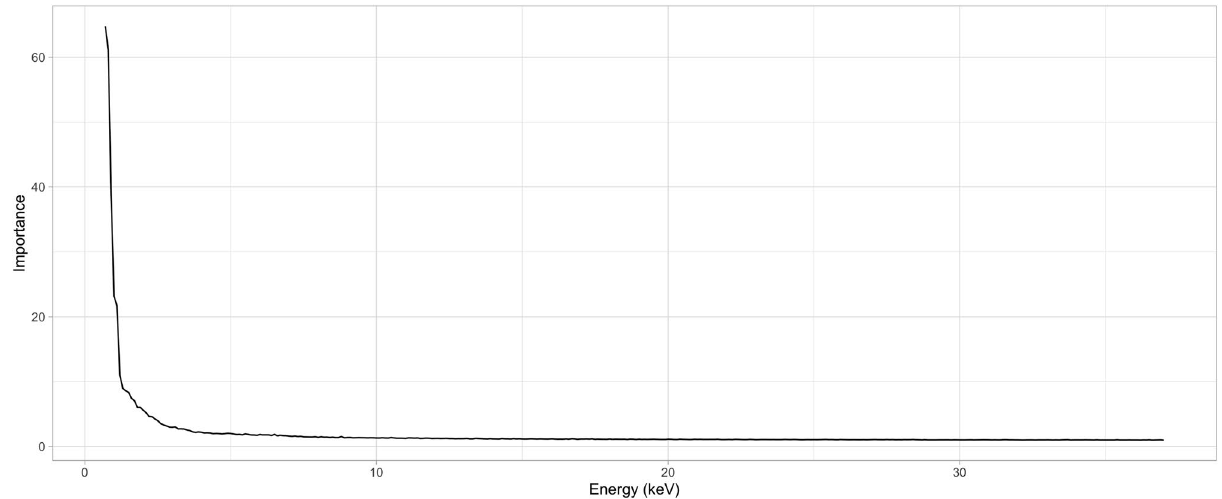
Figure 5. Importance features for the full dataset using categorical crossentropy as a loss function. Note that the most relevant information is included from 0.7 to 1.7 keV.